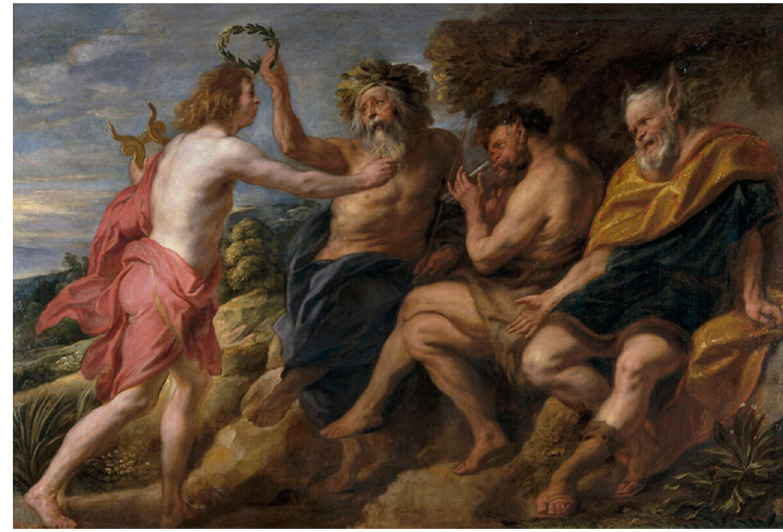
Figure 21: Jacob Jordaens, Apollo as Victor Over Pan , 1637. Museo del Prado, Madrid. Public